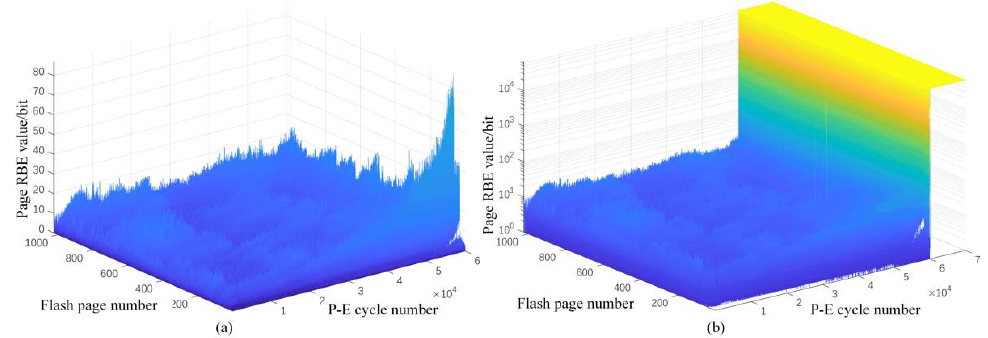
Figure 2. The relationship between the RBE on the page and the P-E cycle number: ( a ) Early and mid in lifecycle; ( b ) End of lifecycle.